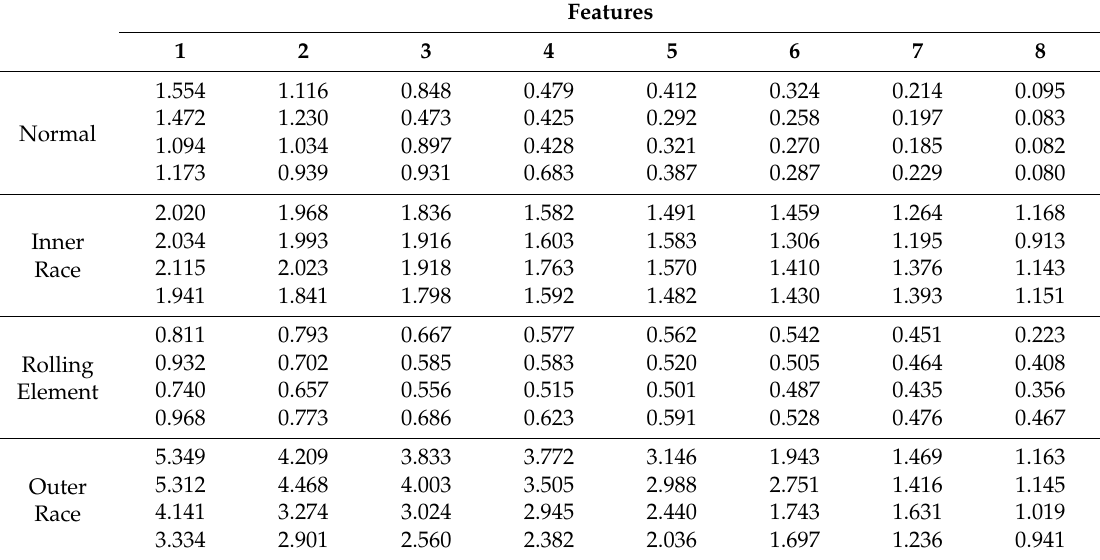
Table 3. The features of decomposed signals.